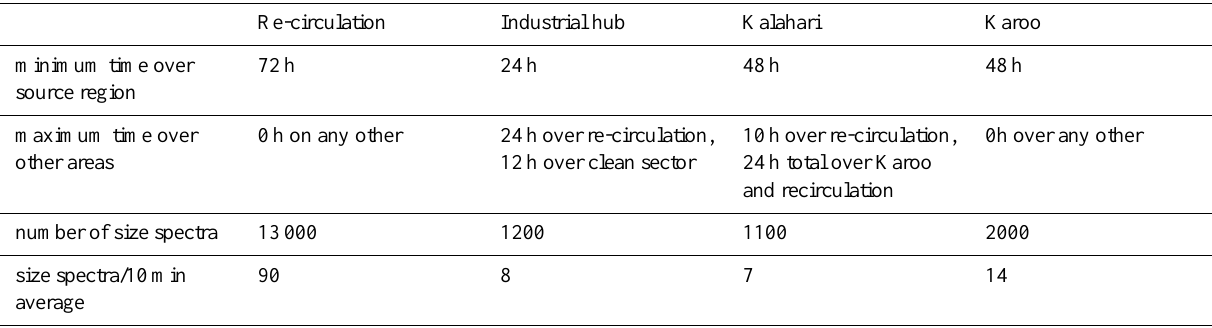
Table 5. Criteria for source region characterisation and the number of size distribution measurements obtained for each source region. Also average number of observations per each 10min average in the average diurnal variation in Fig. 13 is included.